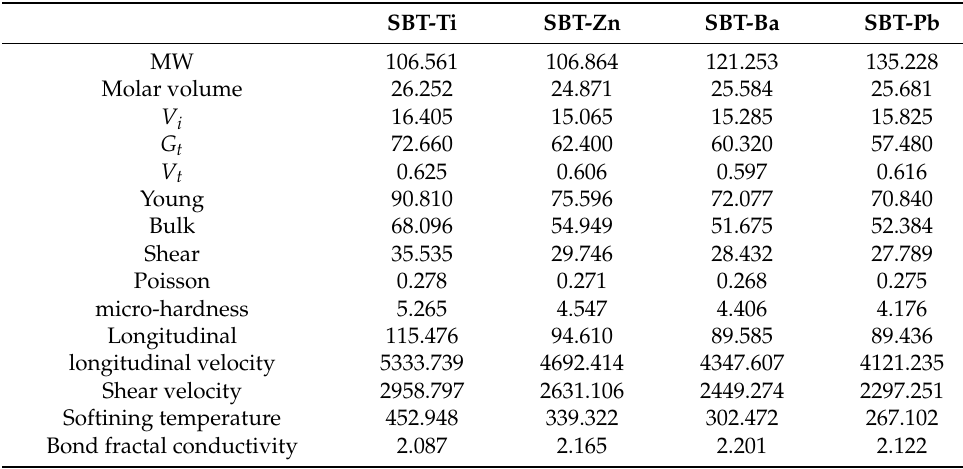
Table 2. Physical and mechanical attributes of the prepared